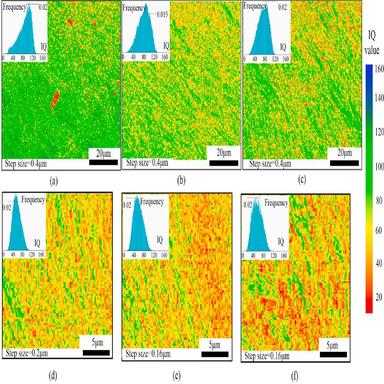
IQ distributions in the cutting deformation zones. (a)–(c) successively present the IQ distributions of the PSZ (I area in a) at 30 m/min, 90 m/min and 150 m/min (d)–(f) present the IQ distributions of SDZ (II area in a) at 30 m/min, 90 m/min and 150 m/min. The sub-figures in (a)–(f) indicate the frequency distribution of the IQ value in the corresponding deformation zones. The colour represents the IQ value as shown in the legend at the right side. (For interpretation of the referenc